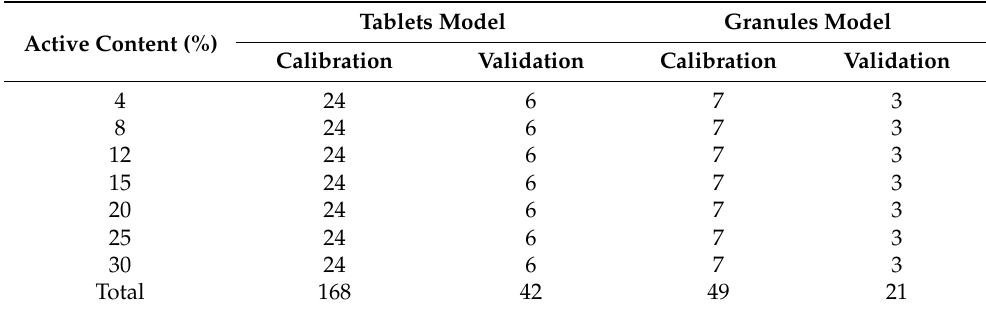
Table 4. Number of calibration and validation samples for building up PLSR models of tablets and granules. Tablets Model Granules Model Active Content (%) Calibration Validation Calibration Validation